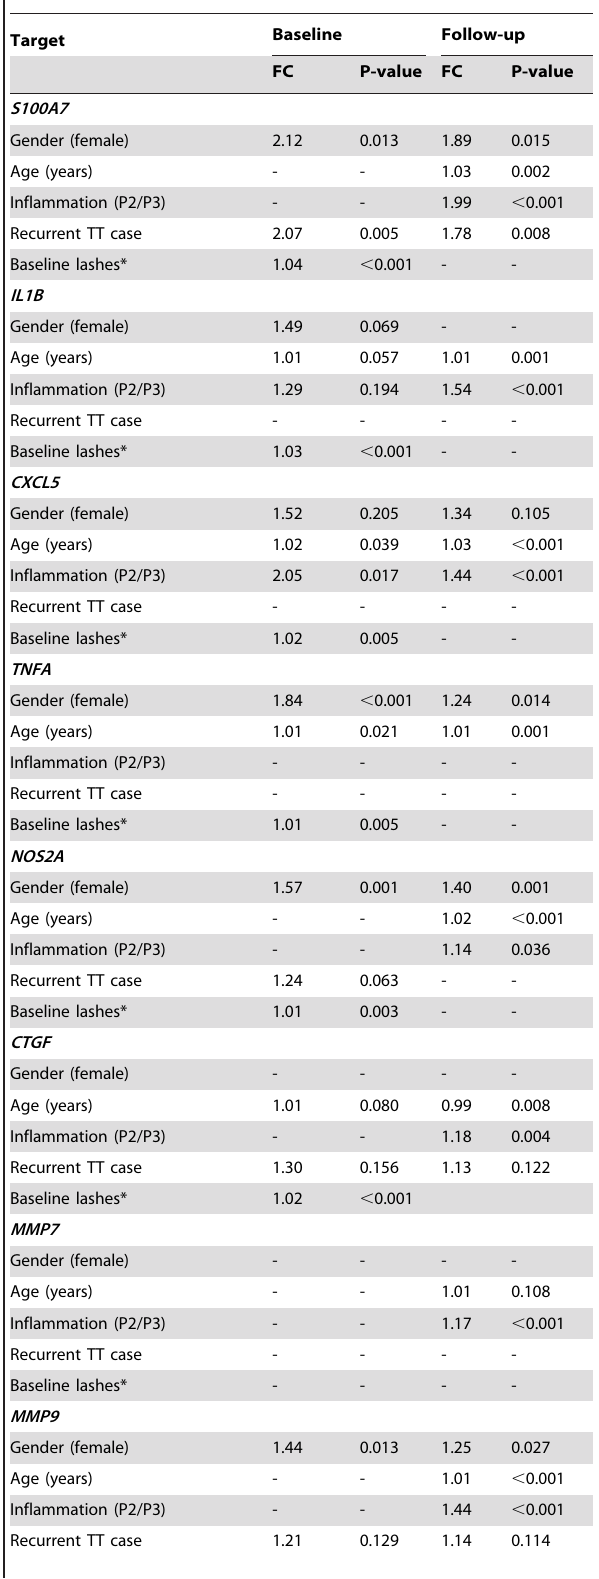
Table 5. Multivariable linear regression models for the expression of each target at baseline and follow-up.